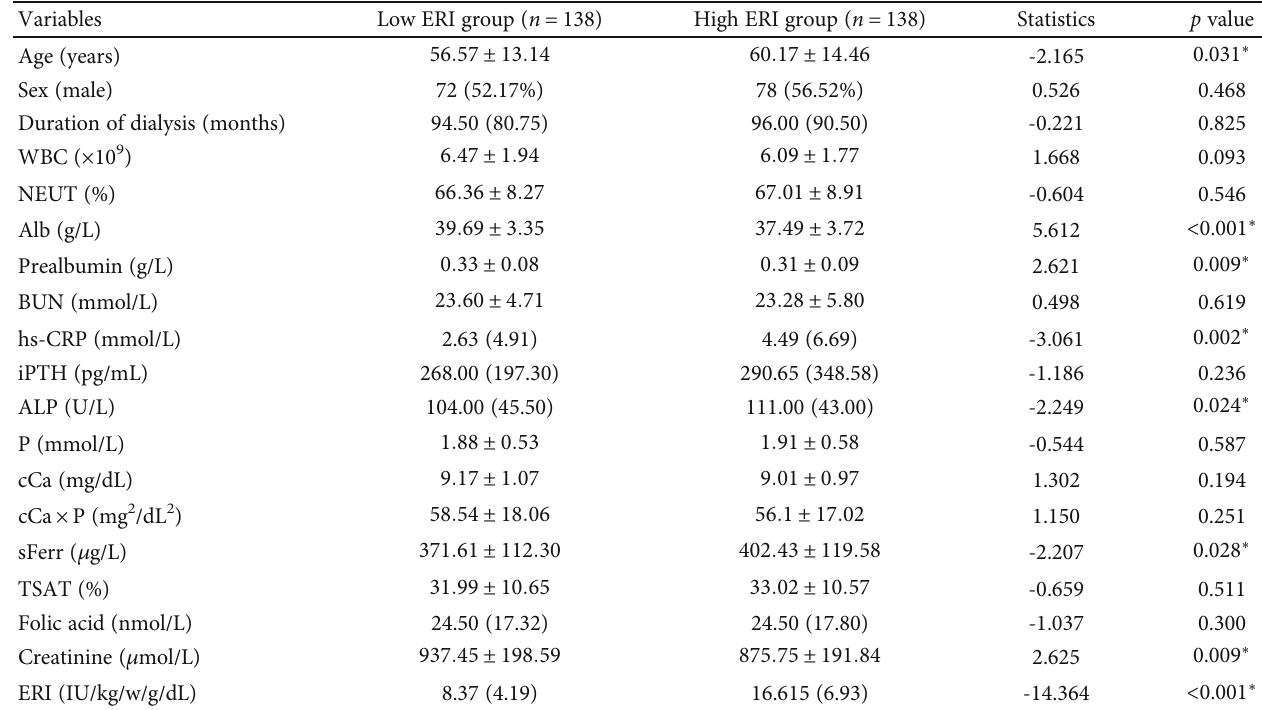
Table 1: Characteristics of patients in the low ERI group and the high ERI group.